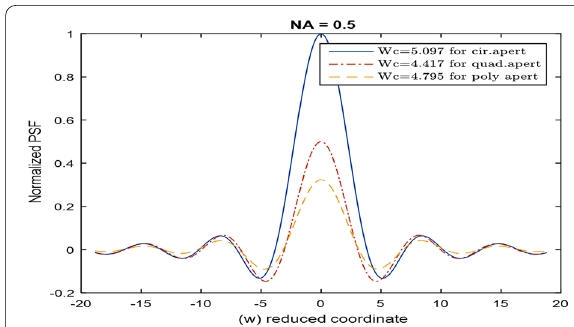
Fig. 6 PSF corresponding to the polynomial aperture (first model) and compared with the corresponding PSF of circular and quadratic apertures using the analytical solution given by Eq. (5)